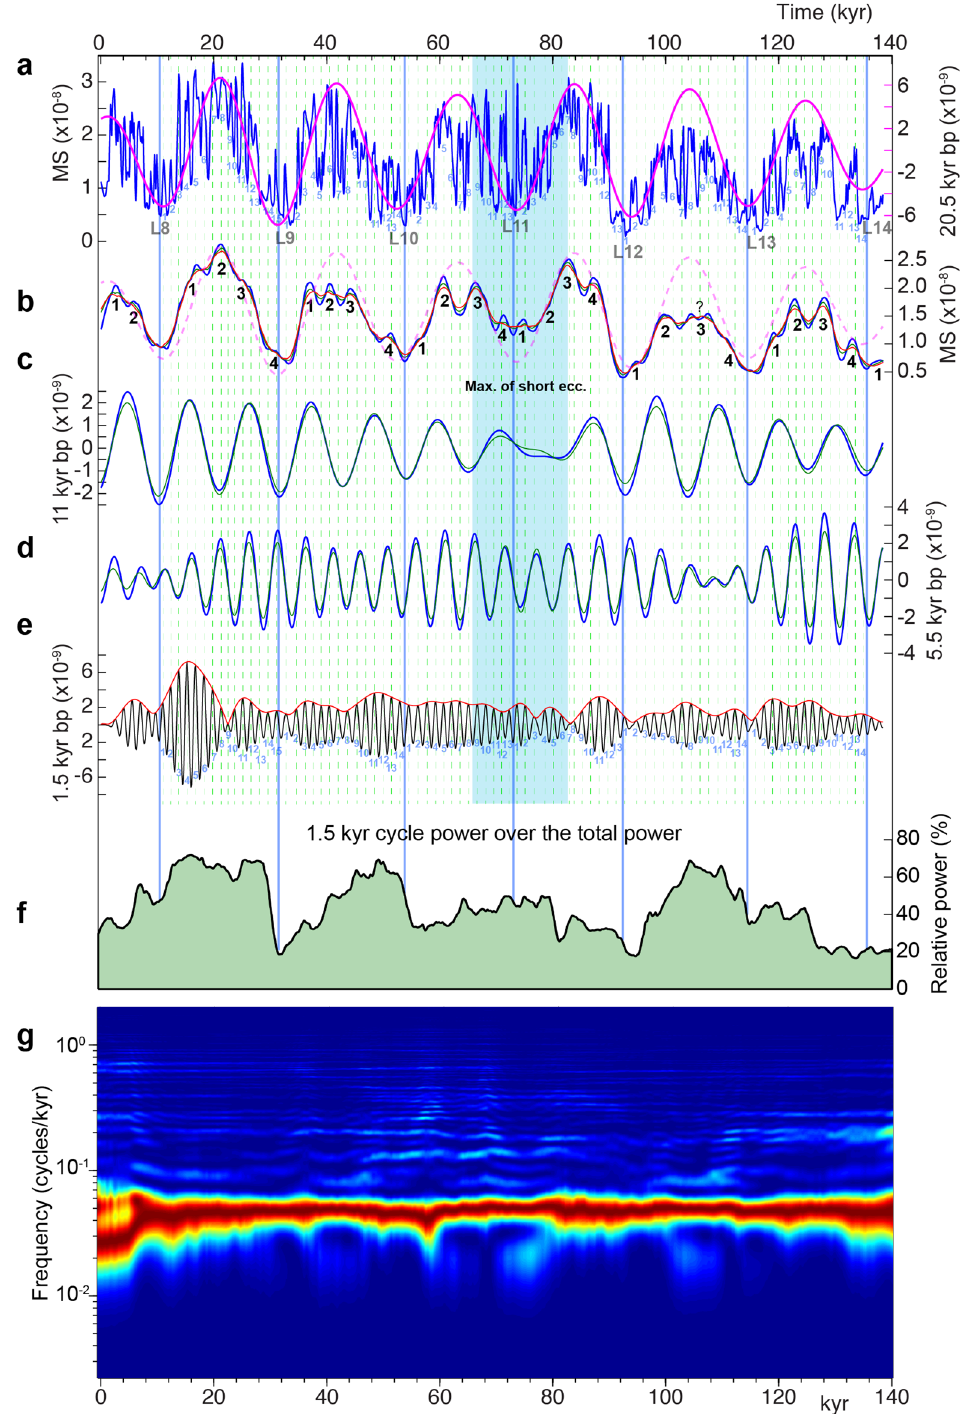
Figure 4. Time-series analysis of the tuned MS data. ( a ) Tuned MS data. The 1.5 kyr cycles, which correspond to the highest frequency cyclicity (marl-limestone couplets), are numbered within each precession cycle, from 1 to 13 or 14. L8 through L14 are as in Fig. 3. (b) SSA first RC1 component indicates precession and its harmonics (half- and quarter-precession). Quarter-precession cycles within each precession cycle are numbered from 1 to 4. (c) Bandpass filtered half-precession cycles from the raw tuned MS. (d) Bandpass filtered quarter-precession cycles from the raw tuned MS. (e) Bandpass filtered 1.5 kyr cycle band along with Hilbert amplitude modulation (AM) envelopes. Light blue-shaded area, within L11 lithostratigraphic marker, indicates a maximum of short eccentricity cycling (see Supplementary figure S8). (f) Evolutive MTM power spectra to highlight the power of the 1.5 kyr cycle relative to the total power of MS signal along the time series. The cutoff frequencies are 0.4 and 1.2 cycles/kyr. (g) Evolutive FFT spectrogram using 50 kyr window and 0.2 kyr step, normalized to the strongest amplitude in order to highlight the precession cycle. The evolutive FFT spectrograms in the stratigraphic domain are shown in the Supplementary figure